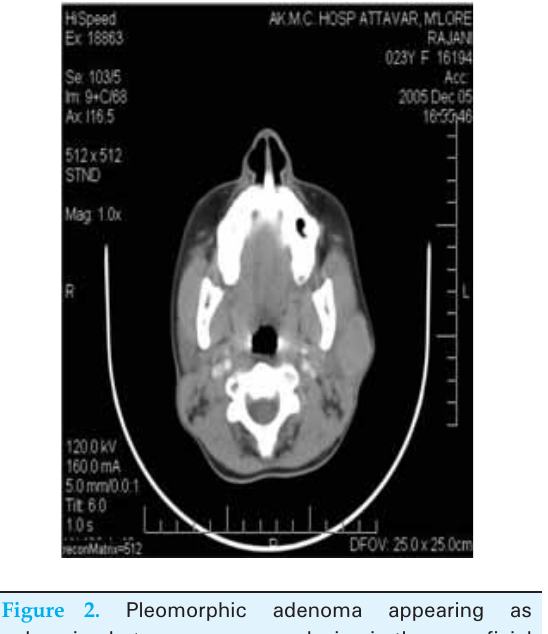
nodes as compared to benign lesions. Metastatic nodal carcinoma of